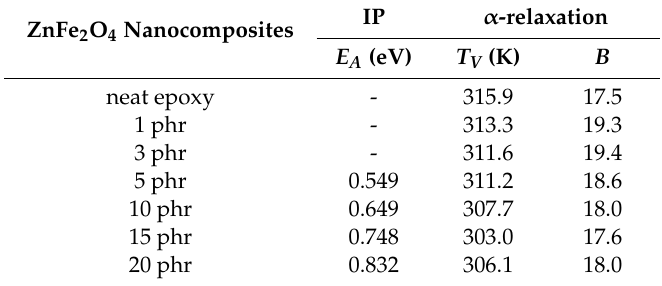
Figure 7. Loss peak position as a function of the reciprocal temperature for the IP and α -relaxation processes, for all the examined systems. Table 1. Specimens’ concentration in phr (parts per hundred per resin per weight), activation energy values and fitted parameters for all examined systems.